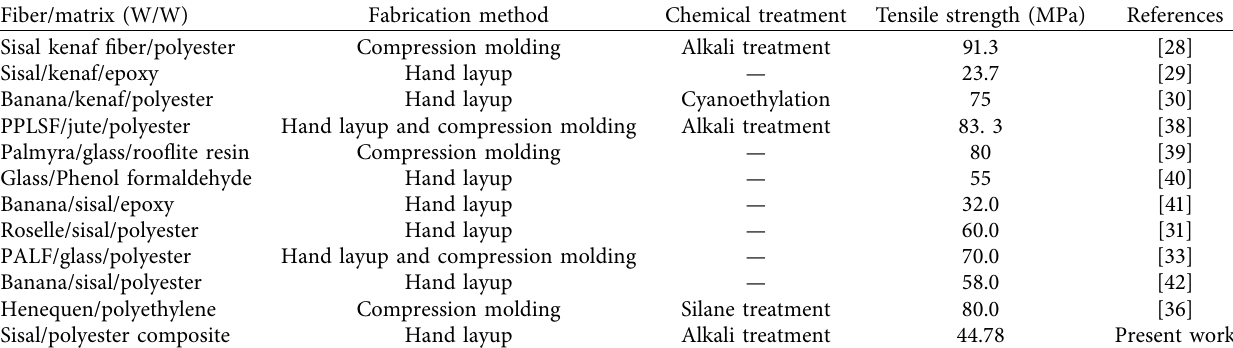
Table 2: Comparison of flexural strength between various existing single and hybrid fiber tensile strengths. Fiber/matrix